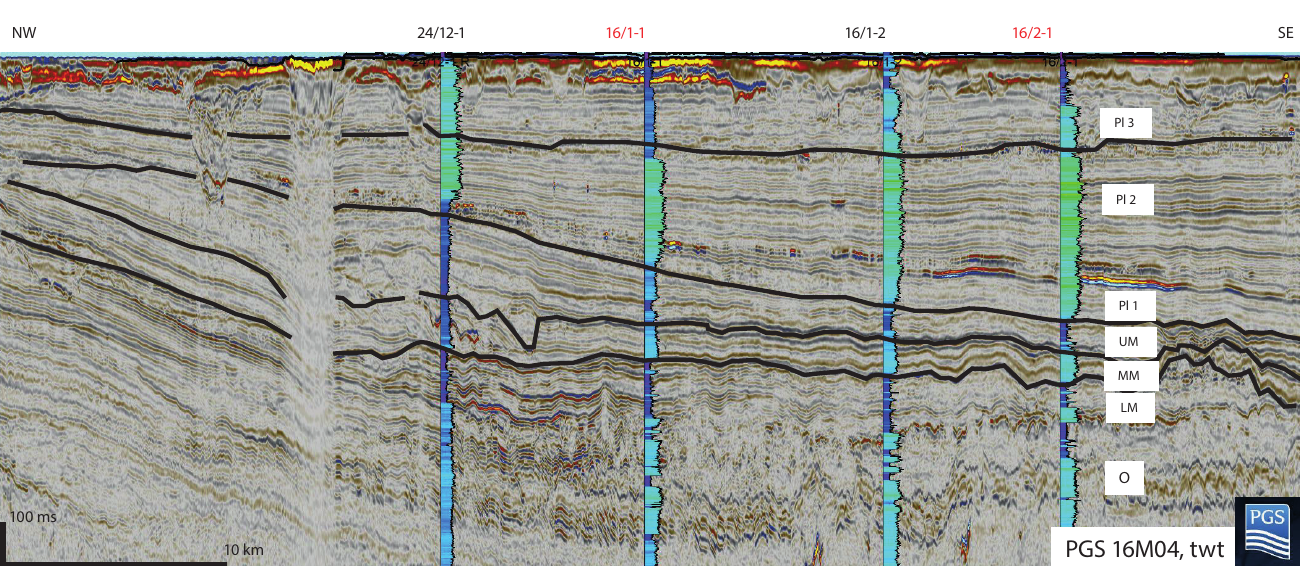
Figure 58. Seismic line crossing the southern part of Viking Graben from west to east. Central part of the Norwegian sector of the North Sea. O: Oligocene, LM: Lower Miocene, MM: Middle Miocene, UM: Upper Miocene and lower Pliocene, Pl: Pleistocene. The line illustrates the progradation to the east of the Miocene Skade (lower Miocene), Eir (middle Miocene) and Beiningen (mainly upper Miocene and lower Pliocene) formations. High values of the gamma logs in the figure can in some places be sand with glauconite. In the middle Miocene, the pinch-out of the western sands is mapped slightly west of 24/12–1, which is transitional, and in the other three wells the section is clayey. The Beiningen Formation and the Skade Formation are sandy farther to the east in this area. In the Pleistocene, progradation from the west takes place in Pleistocene Pl1 (western part of seismic section) and progradation from the east in Pleistocene (Pl2). See Fig. 2 for location. The re-analysed well 24/12–1 and 16/1–2 have black